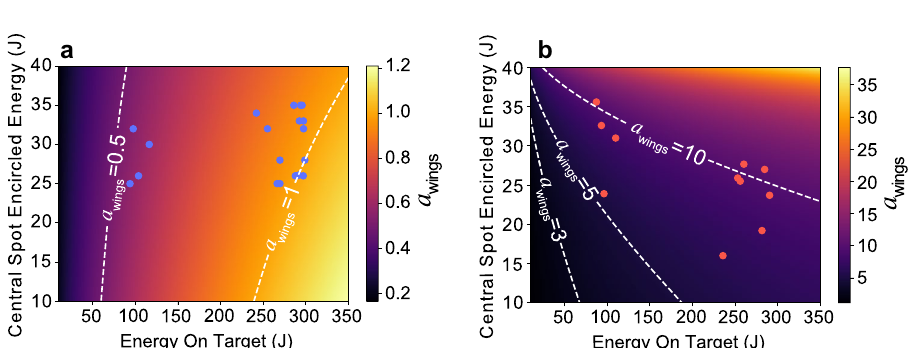
Figure 5. Model results for the normalised vector potential of the wings for both focusing geometries. Calculated values for a wings (colour axes) as a function of peak encircled energy in the main spot (FWHM) and the total laser pulse energy on-target, for ( a ) F/3 focusing and ( b ) F/1 focusing. Both are based on the focal spot distributions measured in the experiment. The calculated values for the specific focal spot distributions for the measurements in Fig. 2 are included as data